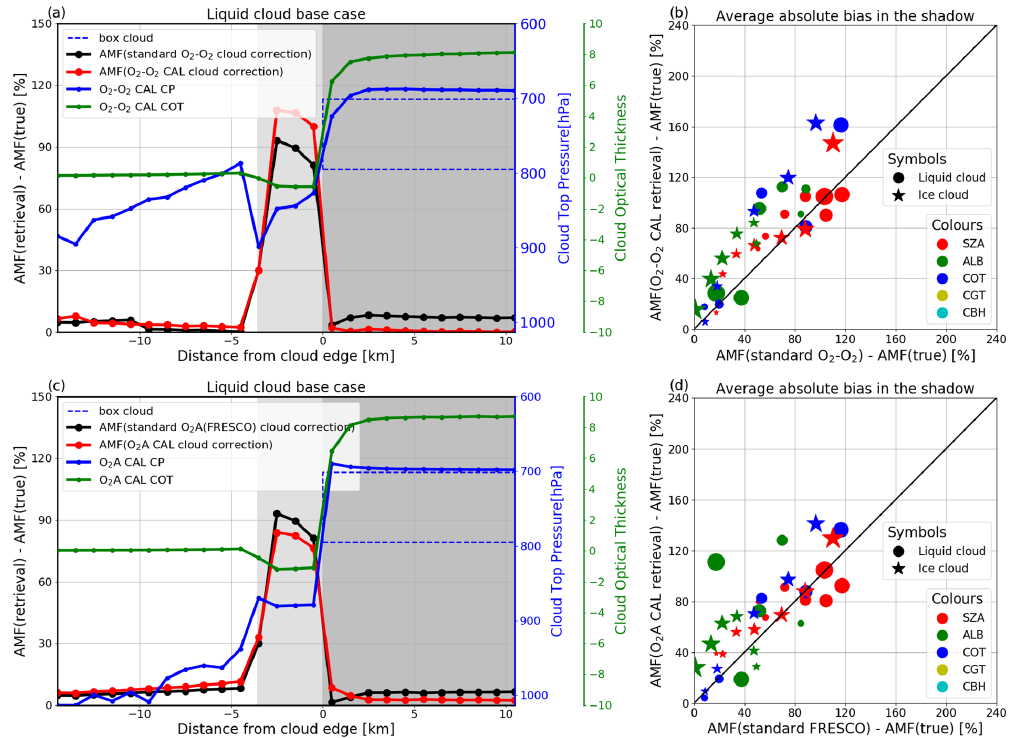
Figure 12. Similar to Fig. 11, but the NO 2 retrieval uses cloud correction based on a clouds-as-layers approach. Cloud pressures given on the right of panels (a) and (c) are cloud top pressures. In (b) and (d) , the x axis on the right represents the retrieval bias based on the NO 2 retrieval using the standard O 2 –O 2 (b) and FRESCO (d) clouds, respectively.